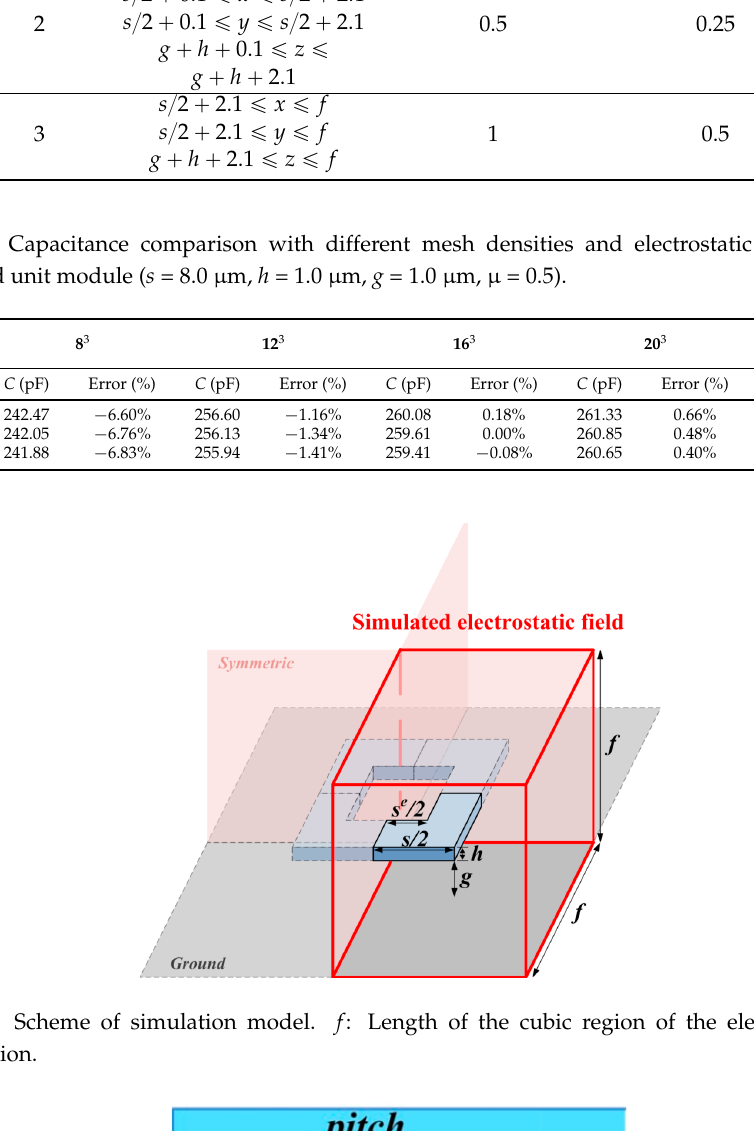
Figure 6. Scheme of ligament coefficient μ = l / pitch . l : The interval between two etching holes.